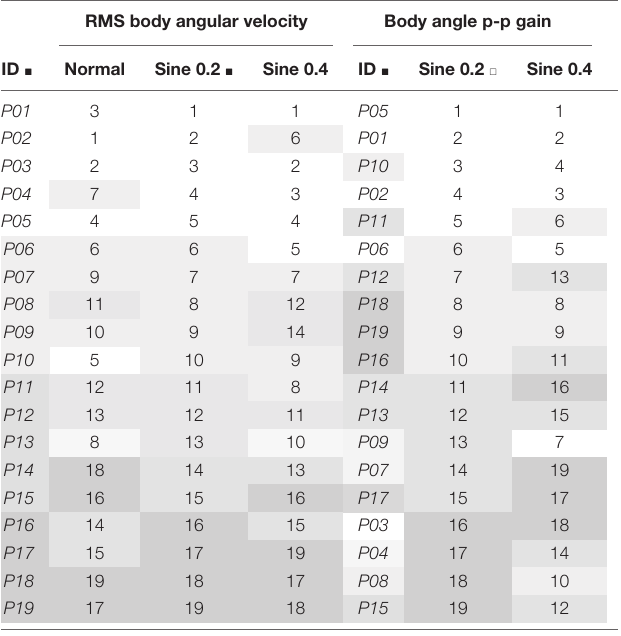
For each measurement, values were ordered and ranked in relation to sine 0.2 condition (columns 3 (cid:4) and 6 (cid:3) , respectively). Participant ID (ID columns 1 (cid:4) and 5 (cid:4) ) was defined based on sine 0.2 condition RMS body angular velocity ranking. Participants were further divided in groups of 4–5, each group represented by different shades of gray. Lighter shades represent lower values. P03 ranked 3rd in RMS body angular velocity in sine 0.2 condition and ranked 2nd in normal and sine 0.4 conditions. The same P03 ranked 16th and 18th in body angle p-p gain in sine 0.2 and sine 0.4 conditions. Order of participants (ID columns 1 (cid:4) and 5 (cid:4) ) varied between two entities due to non-significant correlation between them ( Figure 3A